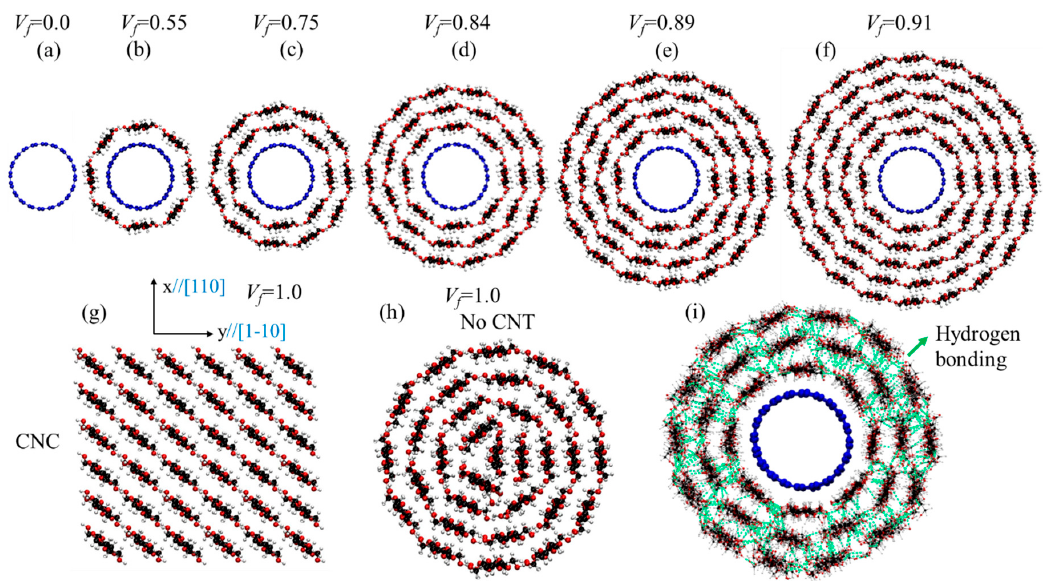
Figure 2. Molecular model of CNT-wrapped with multi-layer cellulose chains at different cellulose content ( V f ). ( a ) V f = 0%, only CNT (10,10) ( b ) V f = 55%, CNT-wrapped with one layer of cellulose. ( c ) V f = 75%, CNT-wrapped with two layers of cellulose. ( d ) V f = 84%, CNT-wrapped with three layers of cellulose. ( e ) V f = 89%, CNT-wrapped with four layers of cellulose. ( f ) V f = 91%, CNT-wrapped with five layers of cellulose. ( g ) V f = 100%, CNC with 36 chains and [110] and [1–10] surfaces. ( h ) V f = 100%, cellulose wrapped with no CNT. ( i ) Hydrogen bonding between chains in multiwalled cellulose nanotube is shown with green dashed lines for V f = 84% after equilibration.